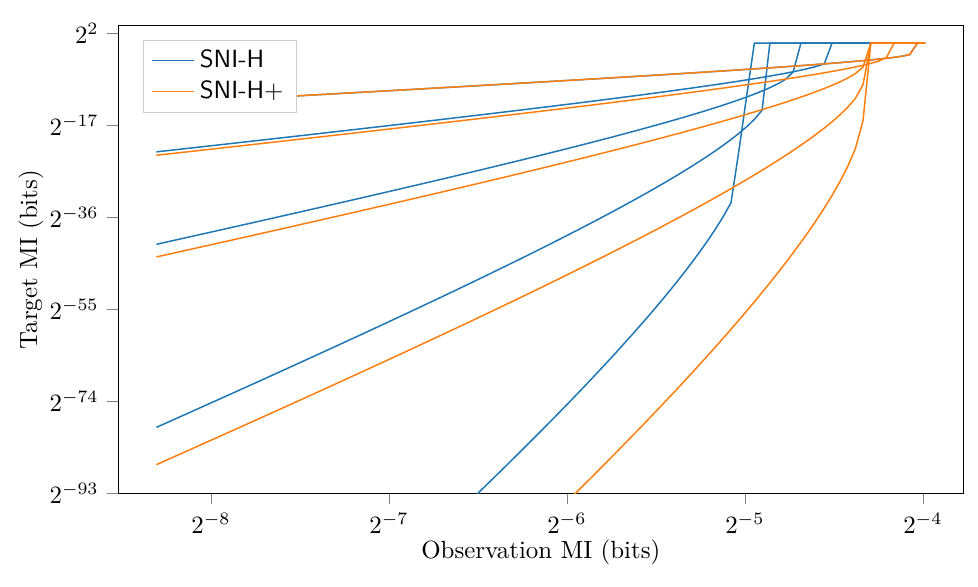
Figure 6: Target MI as a function of observation MI, for the SNI-H and SNI-H+ multipli- cation gadgets at orders t = 1 , 3 , 7 , 15 and